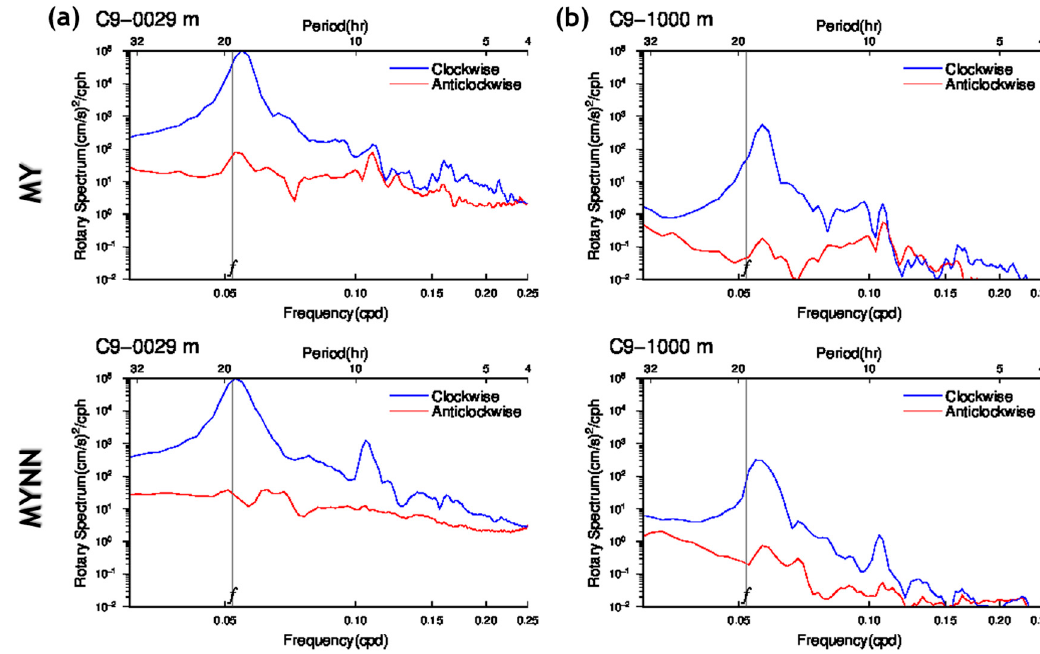
Figure 7. Rotary spectra of the current velocity simulated using the Mellor–Yamada (MY) (top row) and the Mellor–Yamada–Nakanishi–Niino (MYNN) (bottom row) models at depths of ( a ) 29 and ( b ) 1000 m at a point of 133°40.7 ′ E, 38°40.0 ′ N (denoted by the red star in Figures 1 and 2).